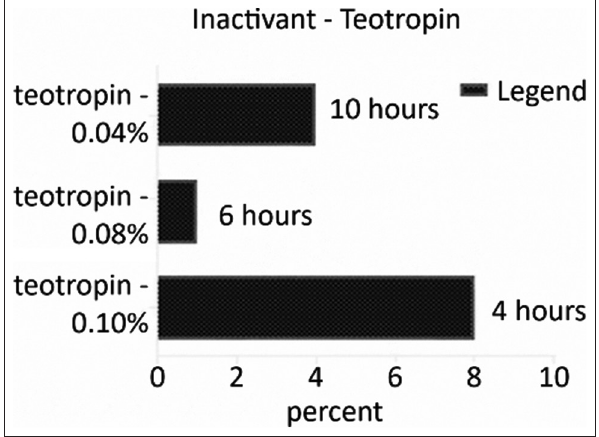
Figure-1: Results of the kinetics of inactivation of the strain “Kordai” of the Aujeszky virus by different concentrations of teotropin at a temperature of the reaction medium.